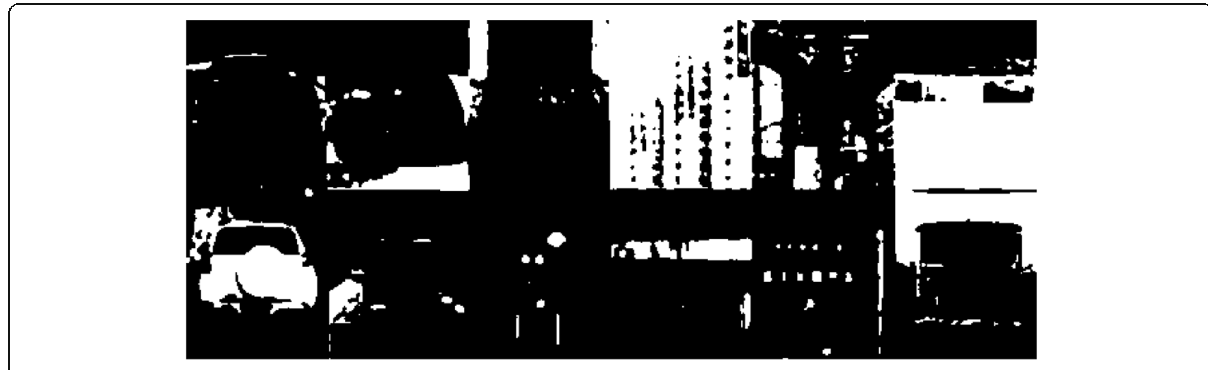
Fig. 11 The results of image